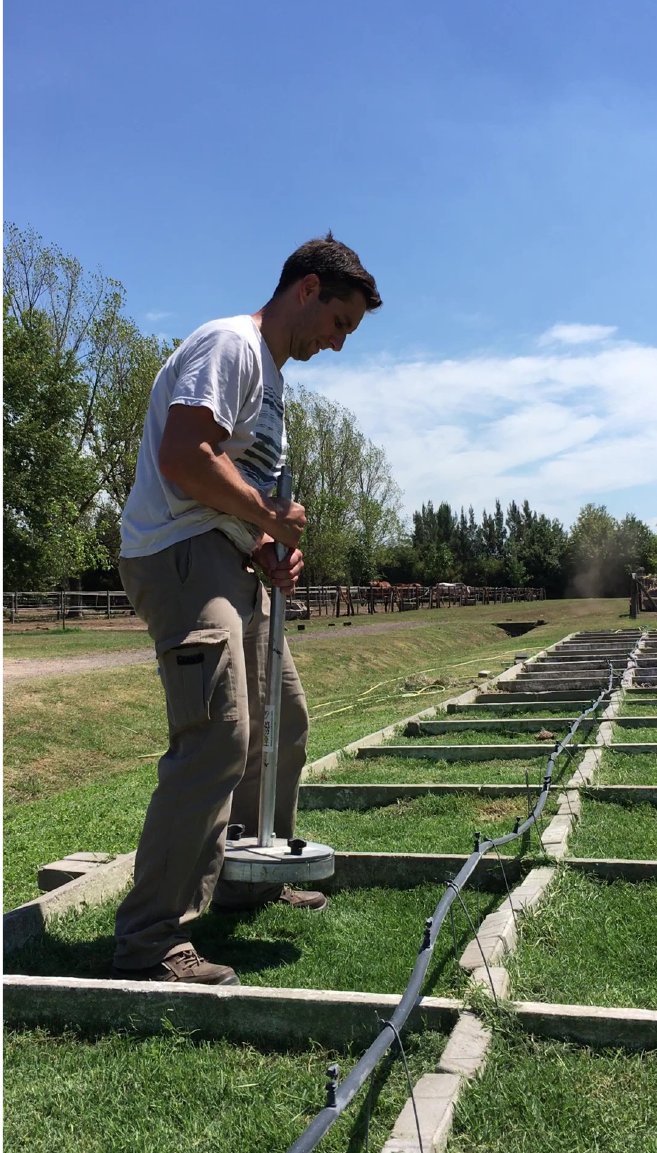
Figure 2. One of the members of the team stood over the boxes of turfgrasses at the moment of the RPS testing (3 March 2018), ©2018 Maria Alejandra Blanco.